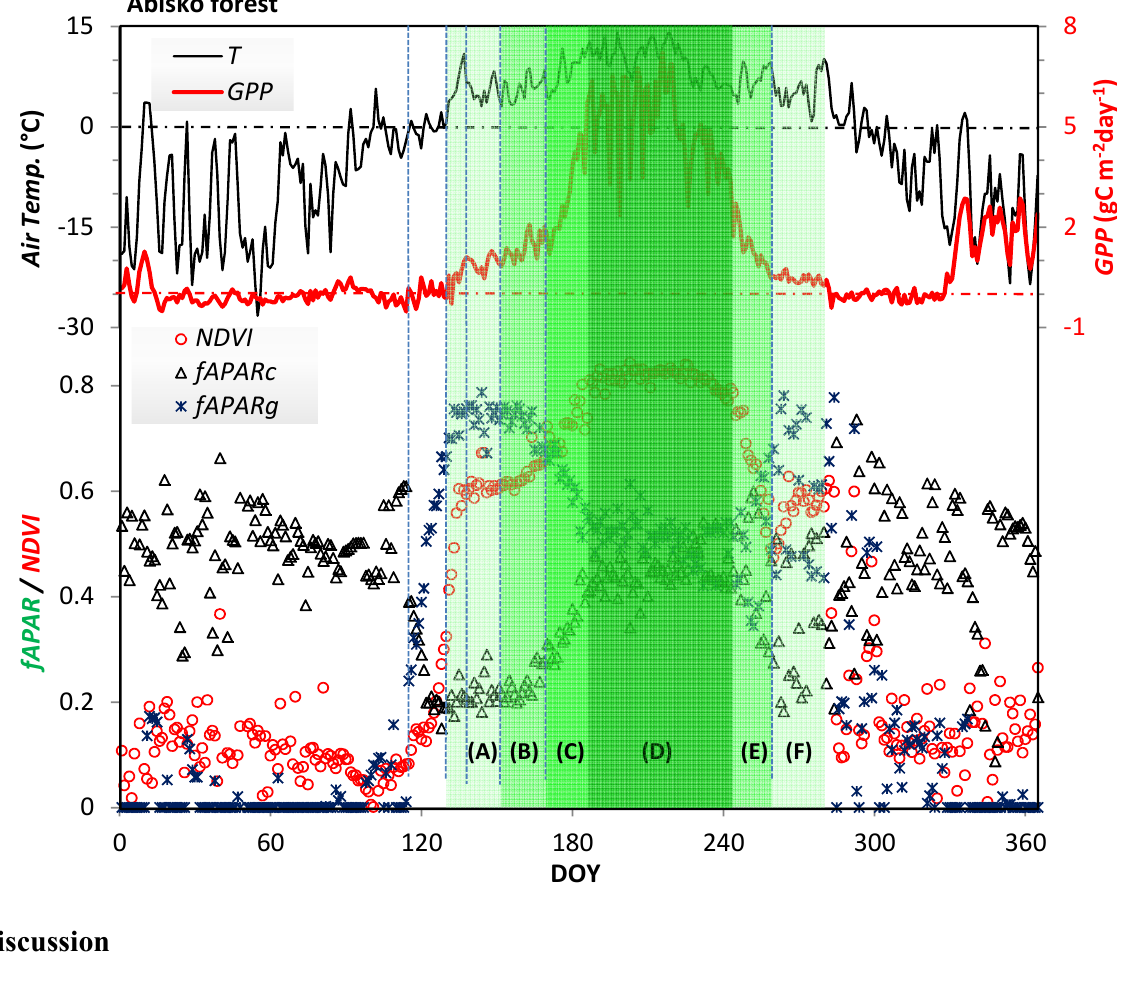
Figure 12. Comparison of NDVI, (cid:1858)(cid:1827)(cid:1842)(cid:1827)(cid:1844) with diurnal GPP and air , and (cid:1858)(cid:1827)(cid:1842)(cid:1827)(cid:1844) (cid:3030) (cid:3034) temperature. Dashed vertical lines show the ground-observed phenology events (Filled circles 1–6): 1. DOY 114 (April 24) half snow, half bare ground, 2. DOY 130 (May 10) end of snow melting, 3. DOY 139 (May 19) birch winter-bud to bud swelling, 4. DOY 148 (May 28) bud swelling to bud growth begins, 5. DOY 168 (June 17) full leaf development, 6. DOY 259 (September 16) all the leaves have become yellowish. Green fields denote vegetation periods (labeled A–F); see the text for